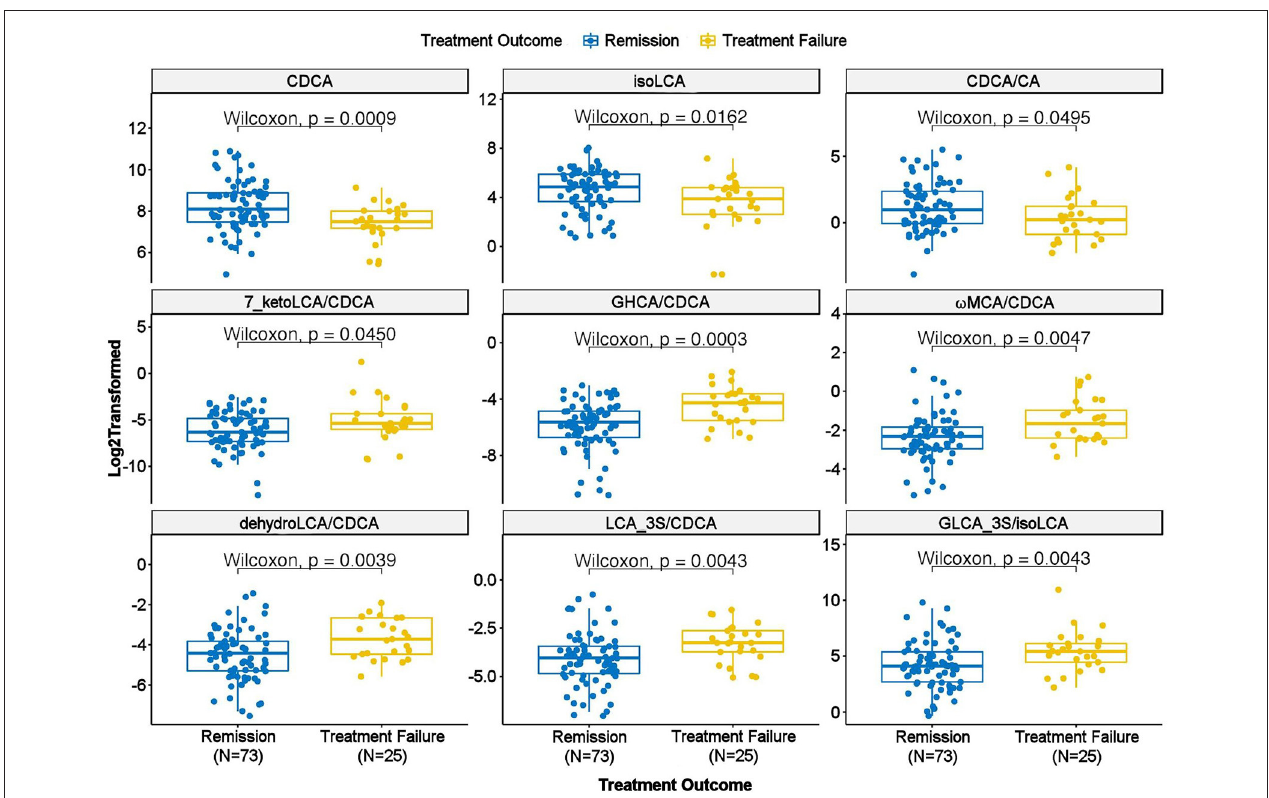
FIGURE 5 | Scatter plot of baseline concentration of selected bile acids and bile acid ratios in treatment failure vs. remission groups. CA, Cholic Acid; CDCA, Chenodeoxycholic Acid; GHCA, Glycohyocholic Acid; GLCA, Glycolithocholic Acid; LCA, Lithocholic Acid; MCA, Monocarboxylic